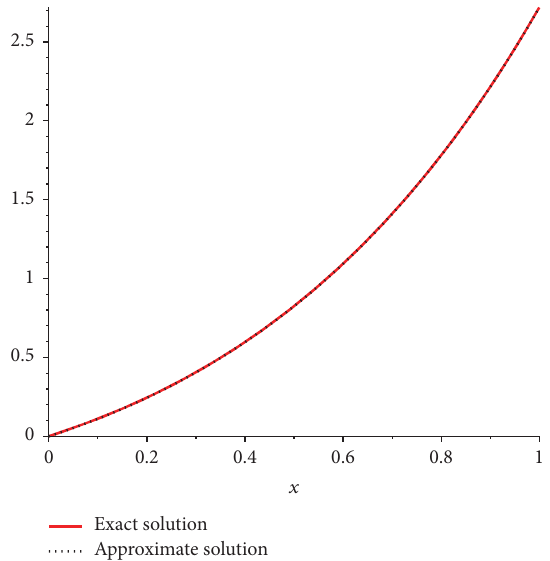
Figure 2: Comparison of exact solution 𝑓(𝑥) and approximate solu- tion 𝑓 ∗ (𝑥) for Example